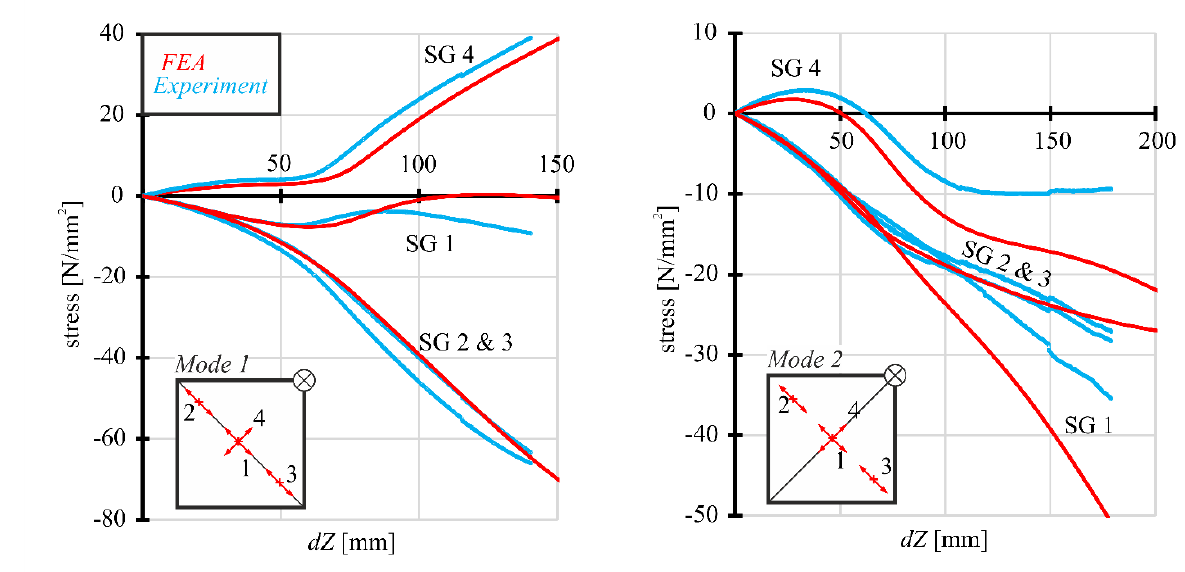
Fig. 8 Experimental and numerical stresses of 4 mm panes in dependence of their deformation mode: (left) Mode 1, (right) Mode